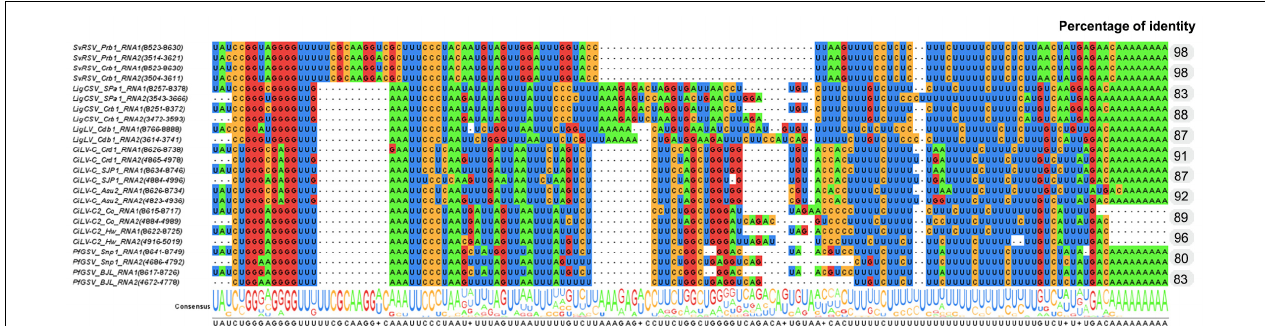
FIGURE 4 | Identification of conserved nucleotide sequences in the 3 (cid:48) -end genomic segments of isolates of Solanum violifolium ringspot virus (SvRSV), Ligustrum chlorotic spot virus (LigCSV), and Ligustrum leprosis virus (LigLV). Values in the column on the right indicate the nucleotide sequence identity between the 3 (cid:48) -termini of RNA1 and RNA2 viral segments. Genomic sequences of several isolates of the cileviruses CiLV-C, CiLV-C2, and PfGSV were also included in the study highlighting conserved nucleotide stretches across definitive and putative members of the genus Cilevirus